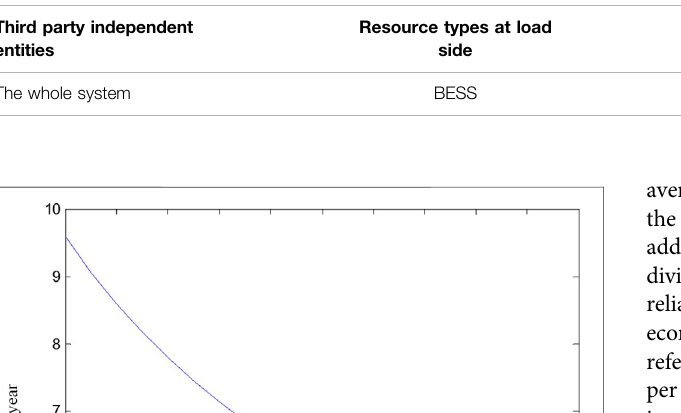
TABLE 4 | Bene fi t for reliability improvement.